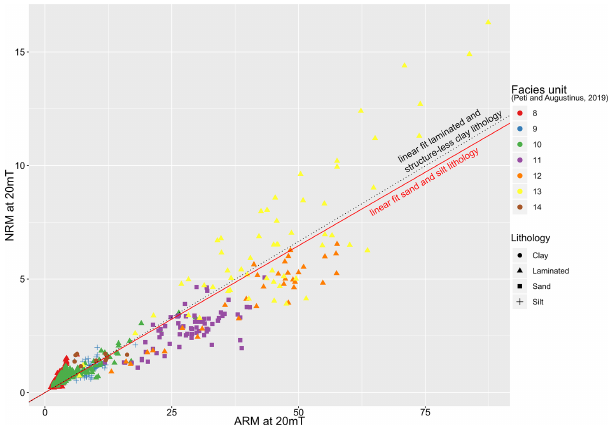
Figure C5. Orakei ARM vs. NRM at 20mT. Note how data points in coarser units with sandy and silty lithology follow a linear trend with a slightly shallower slope (solid red line) than clay-dominated lithologies (dotted black line; laminated or structure-less).